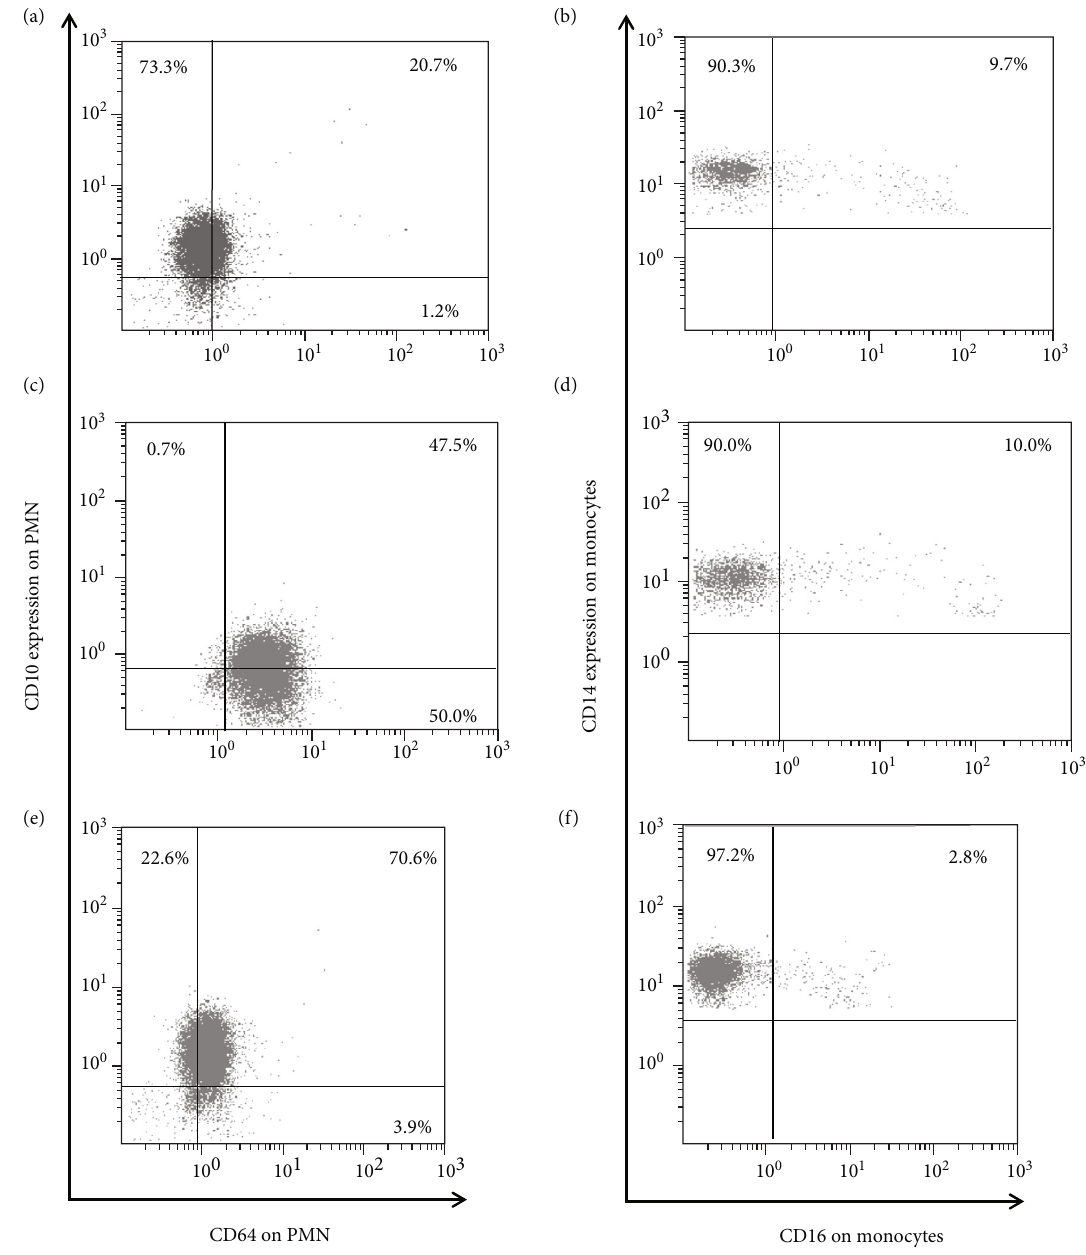
Figure 4: The intensity of expression of CD64 and CD10 on PMN (a, c, e) and CD14 and CD16 on monocytes (b, d, f), in a CVID patient in di ff erent clinical conditions. (a, b) At diagnosis. (c, d) Three months later during an upper respiratory infection with rash. (e, f) Rest state fi ve months after the recovery of